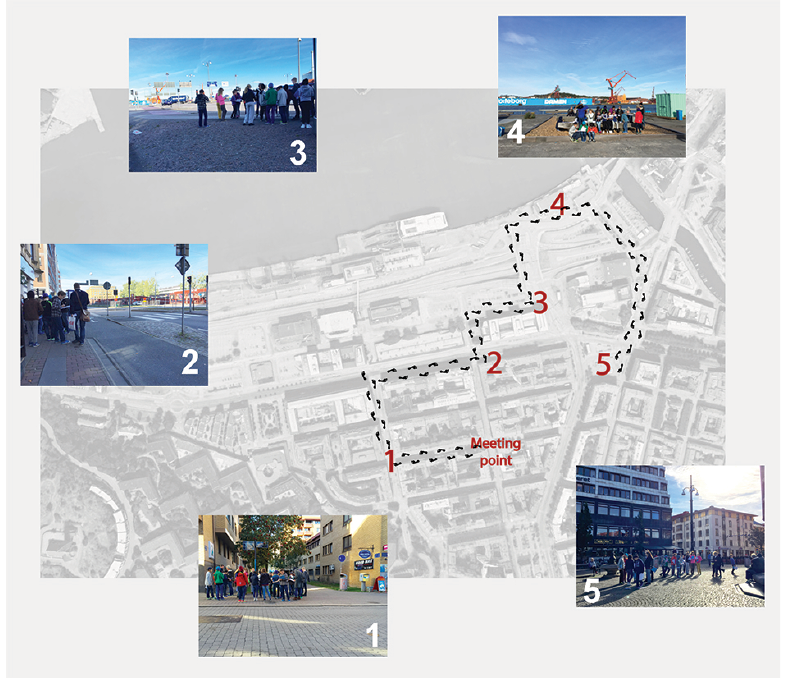
Figure 2. Soundwalk map: